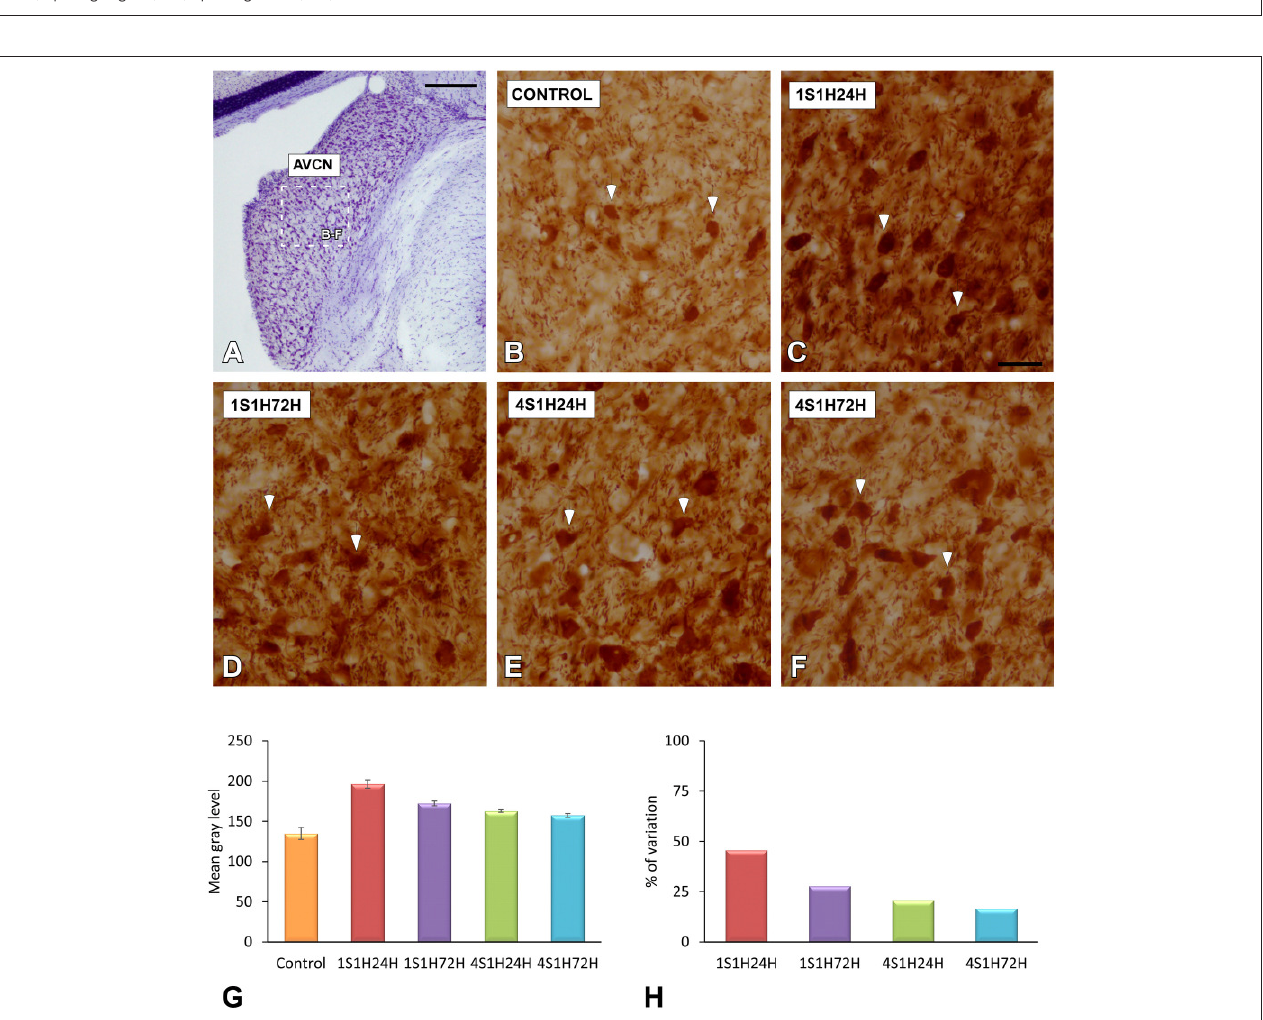
FIGURE 8 | Digitized images illustrating CR immunostaining in the AVCN in control and experimental Wistar rats. At 24h after the first session of sound conditioning, CR levels in both neurons and neuropil were increased (arrows in C ), and continued elevated in 1S1H72H (arrows in D ), 4S1H24H (arrows in E ), and 4S1H72H (arrows in F ) conditions when compared to control rats (arrows in B ). Bar graphs show the mean gray level of CR immunostaining (G) and its percentage of variation (H) in the experimental conditions relative to control. The square box in (A) indicates the approximate location of the high-magnification images shown in (B–F) . Scale bars represent 250 µ m in (A) , and 50 µ m in (C) .